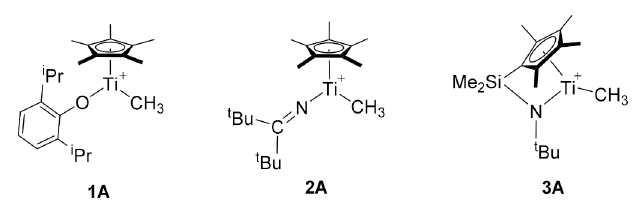
Figure 1. The proposed active species 1A , 2A , and 3A .